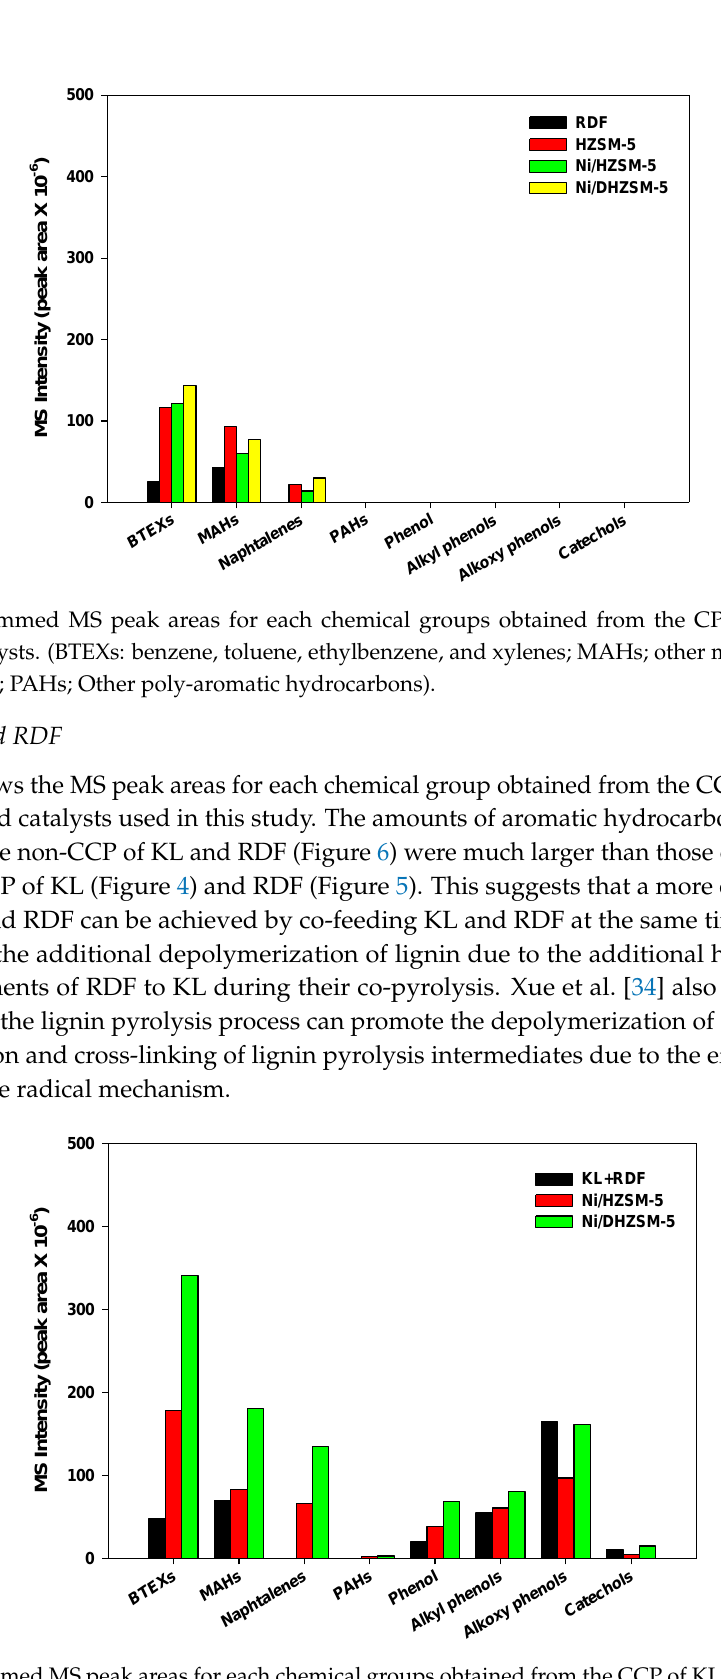
Figure 6. Summed MS peak areas for each chemical groups obtained from the CCP of KL and RDF over different catalysts. (BTEXs: benzene, toluene, ethylbenzene, and xylenes; MAHs; other mono-aromatic hydrocarbons; PAHs; Other poly-aromatic hydrocarbons).